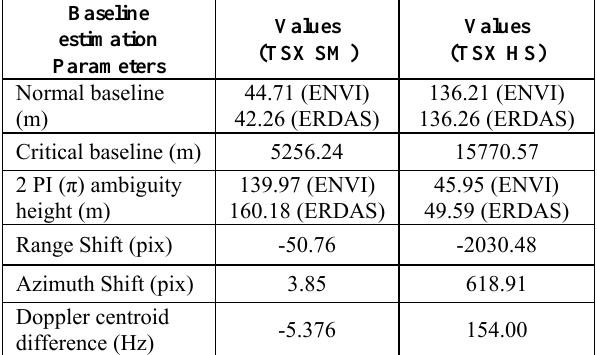
Table 3. Baseline estimation between TSX SM and HS master and slave